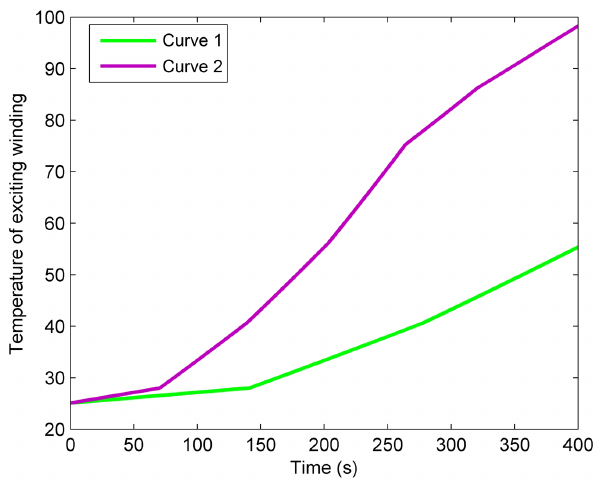
Figure 16. Temperature rising curves of the exciting winding under different braking